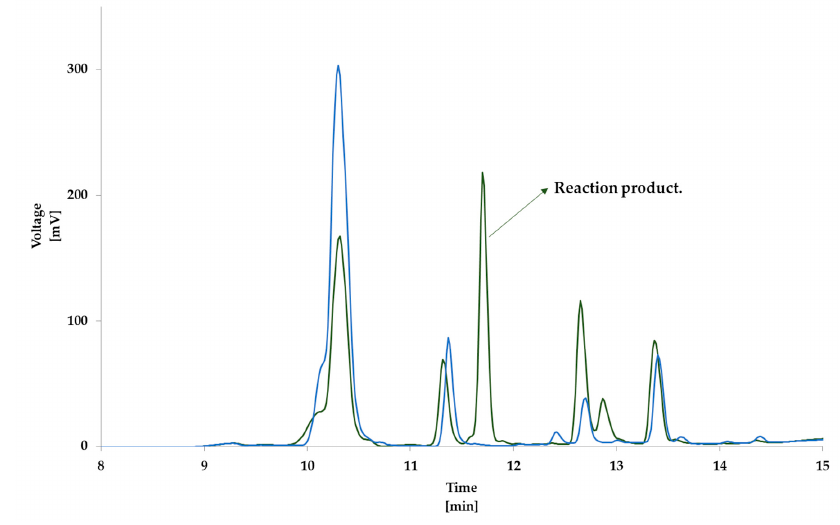
Figure 2. Overlaid chromatograms of N α -benzoylglycyl- L -lysine and derivatives in the blank sample (blue) and the reaction mixture (green) incubated in the same conditions (60 min, 160 °C). In the mixture, there is the formation of a reaction product (retention time R.T.: 11.7 min).